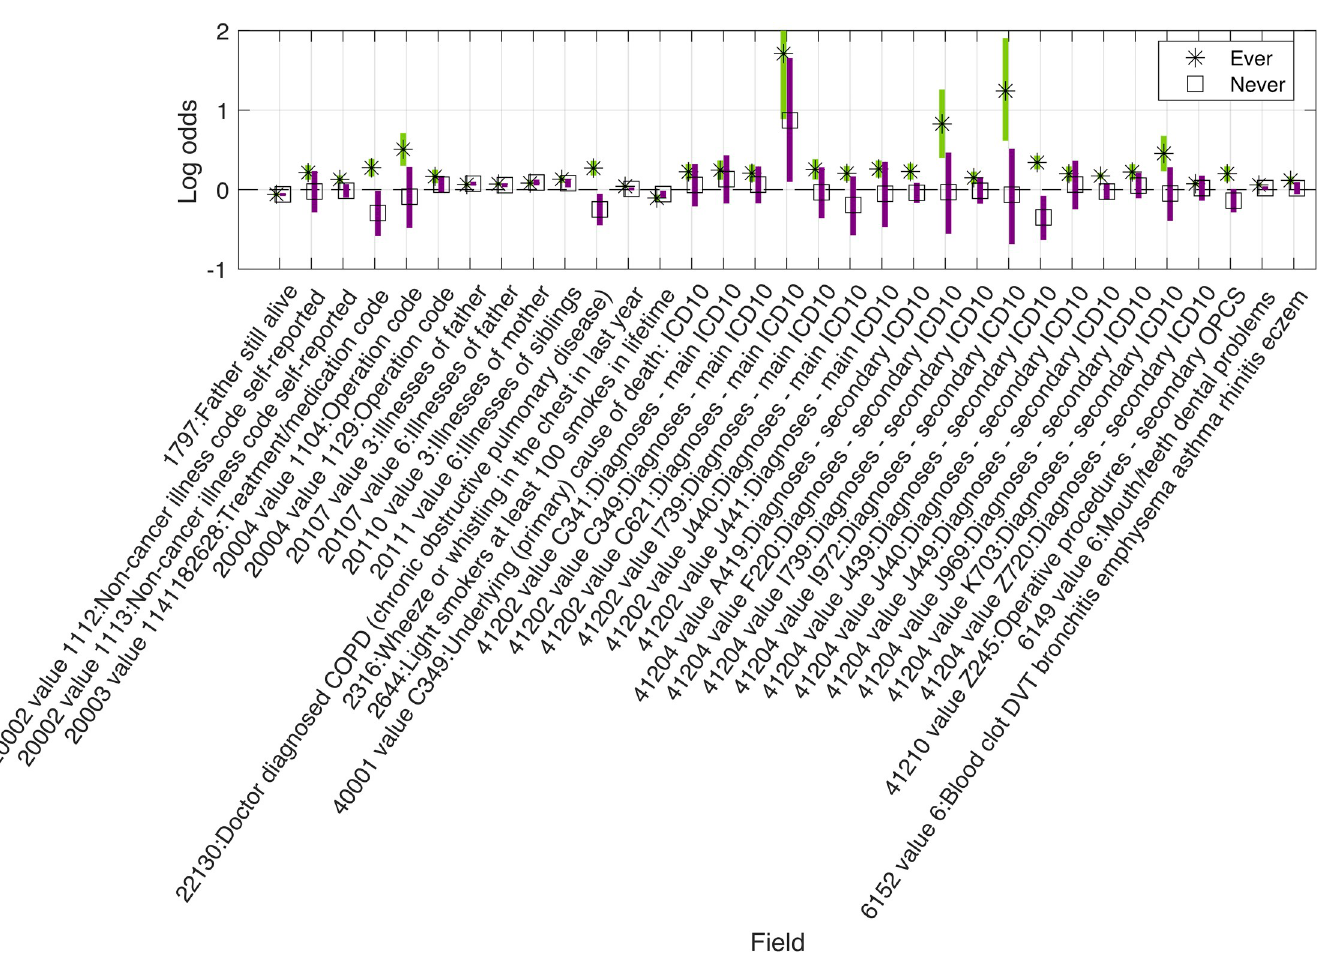
Fig 3. Identified main effects from MR-pheWAS in ever smokers, for binary outcomes. Results shown are those identified after correcting for multiple testing. 33 of 38 binary results are shown in this figure, with PHESANT binary result for never smokers. Results not shown in this figure are relevant to smoking participants only, e.g. ‘difficulty not smoking for 1 day’ such that they are absent in the never smokers (see S3 Table for further